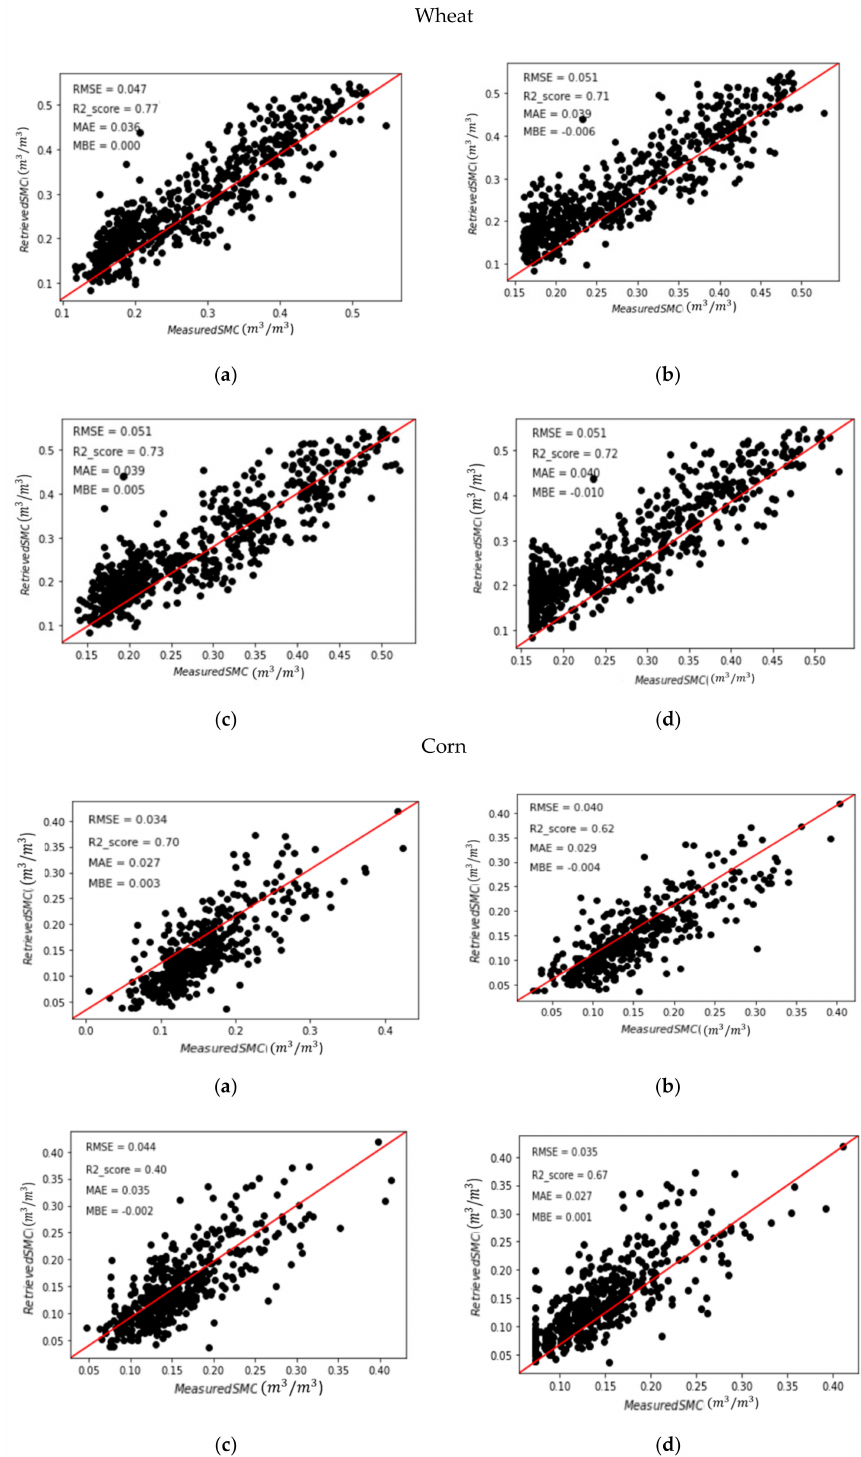
Figure 5. Soil moisture retrieved using a Neural Network algorithm plotted against field-measured soil moisture. Four plots are provided for each crop type (soybeans, wheat, and corn). For each crop type, soil moisture retrieval results are provided based on ( a ) all extracted features, and also using features selected by ( b ) trial and error, ( c ) FFS, and ( d ) BFS selection